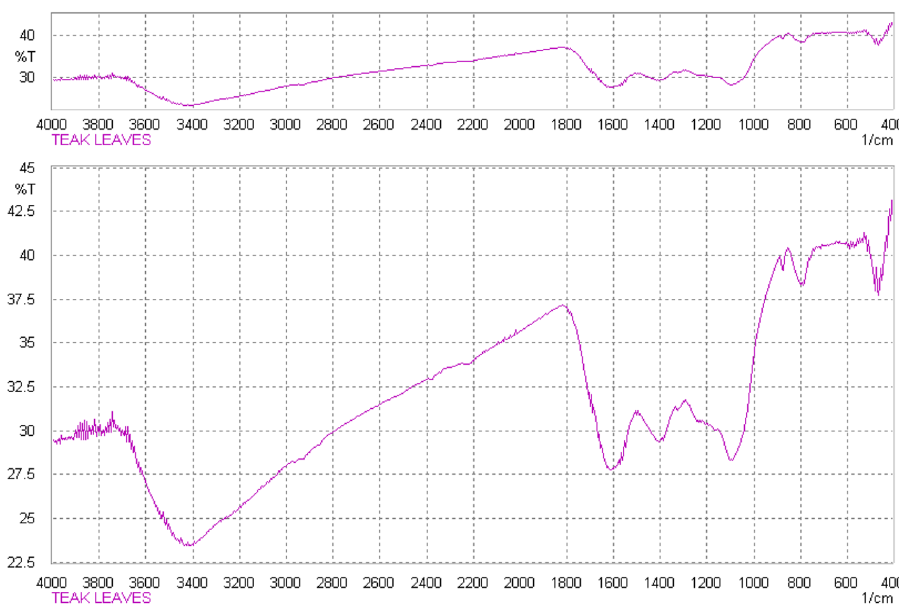
Fig. 2 FTIR spectrum of TLP before